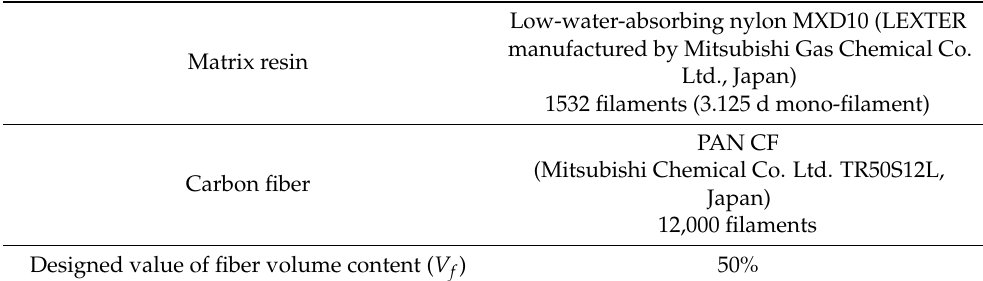
Table 1. Specifications of commingled yarn (Manufacturer ; Kajirene Co. Ltd., Kanazawa, Japan)